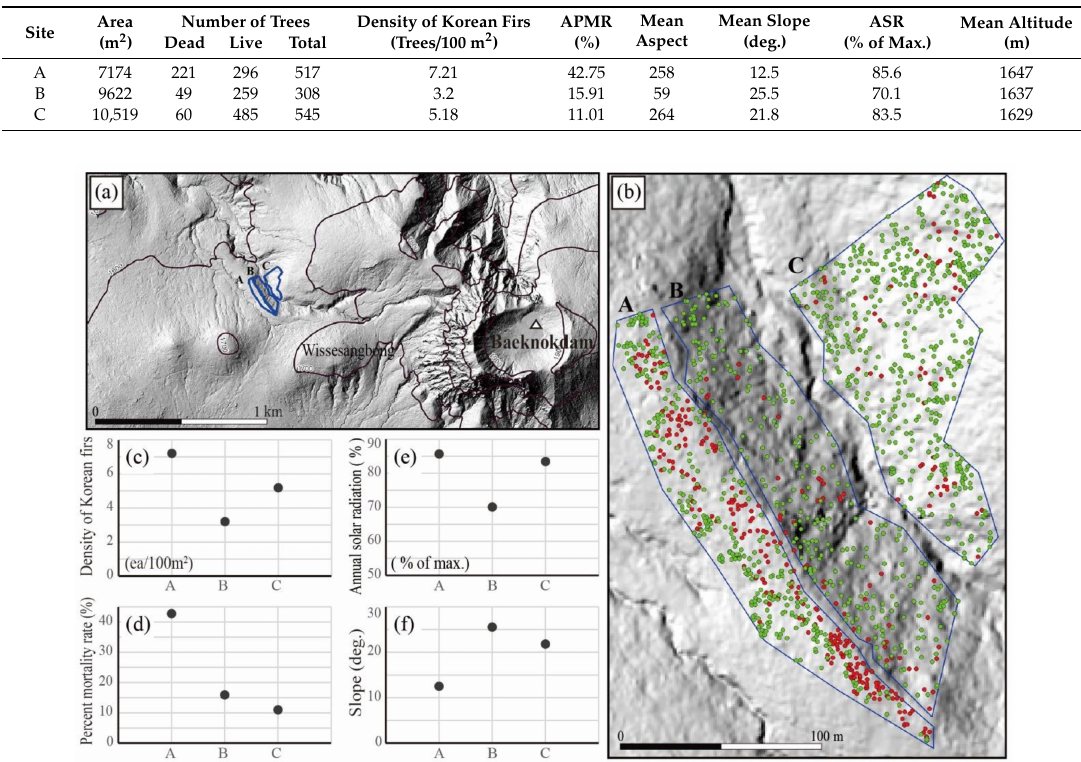
Figure 6. Distribution of the Korean fir ( c – f ) in the small area with heterogeneous topography, where it can be assumed that the rainfall is uniform throughout the area. The location of the site is marked with a star in Figure 2d ( a , b